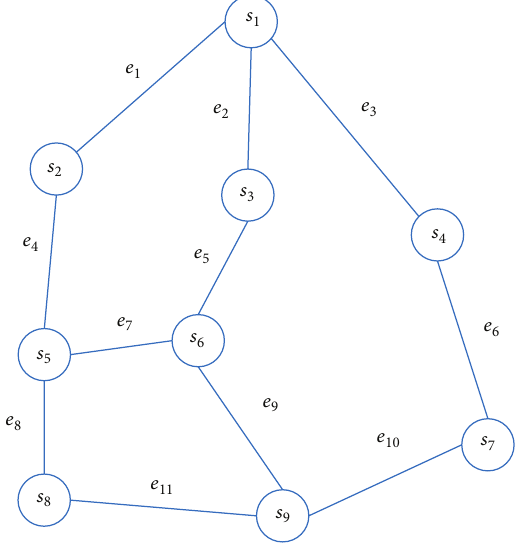
Figure 6: Structure of railway physical network. Table 1: Freight demands and their candidate